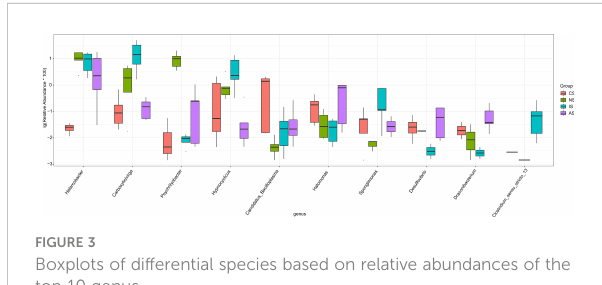
FIGURE 3 Boxplots of differential species based on relative abundances of the top 10 genus.